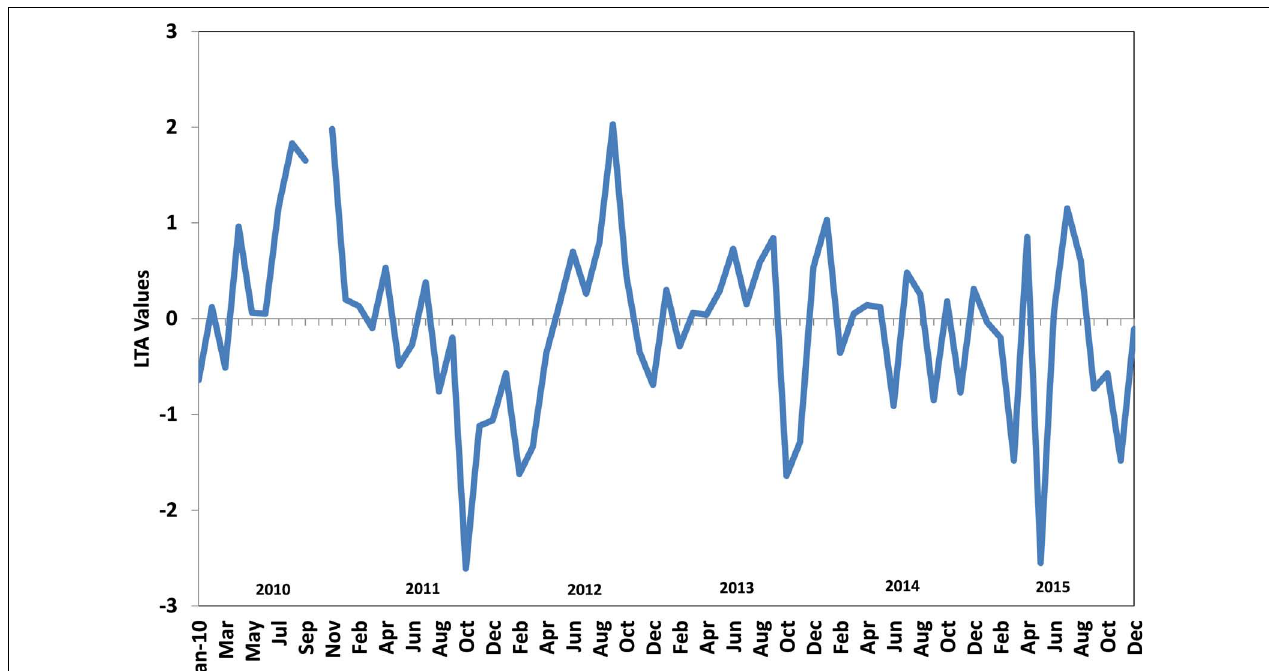
FIGURE 10 | Monthly Local Thermal Anomaly (LTA) values from 2010 to 2015 in the oil sardine fishing grounds off Kochi, southeastern Arabian Sea.